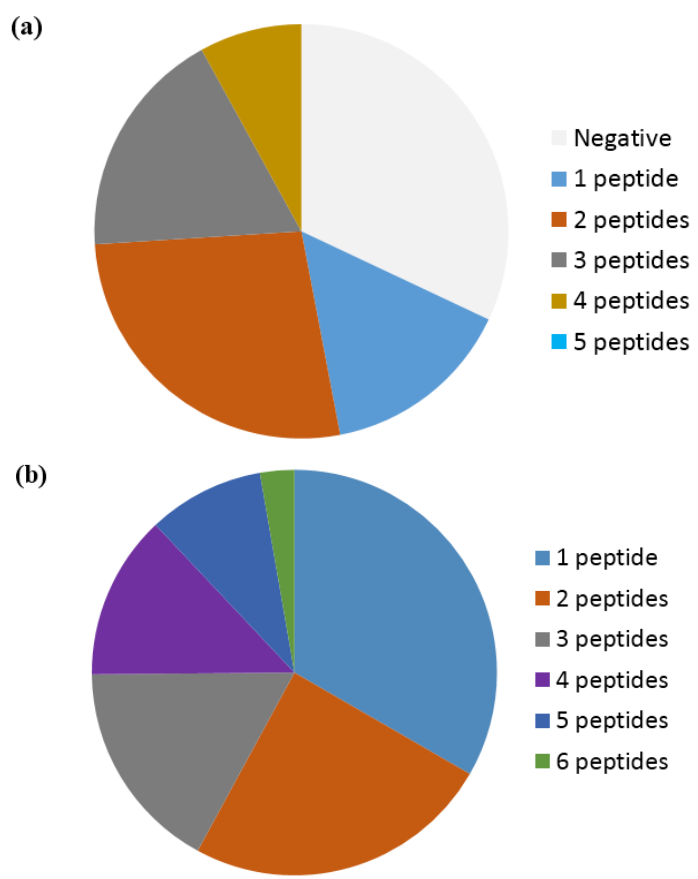
Figure 5. Reactivity of rheumatoid arthritis sera to linear citrullinated peptides. ( a ) Reactivity of 60 RA sera to five selected EBNA-1 peptides [136]; ( b ) Reactivity of 141 RA sera to six citrullinated peptides (vim 60 − 75 , α -enolase 15 − 21 , fibrin 617 − 31 , col-II 358 − 75 , filaggrin 306 − 24 , PAS 621 − 40 ) [113].